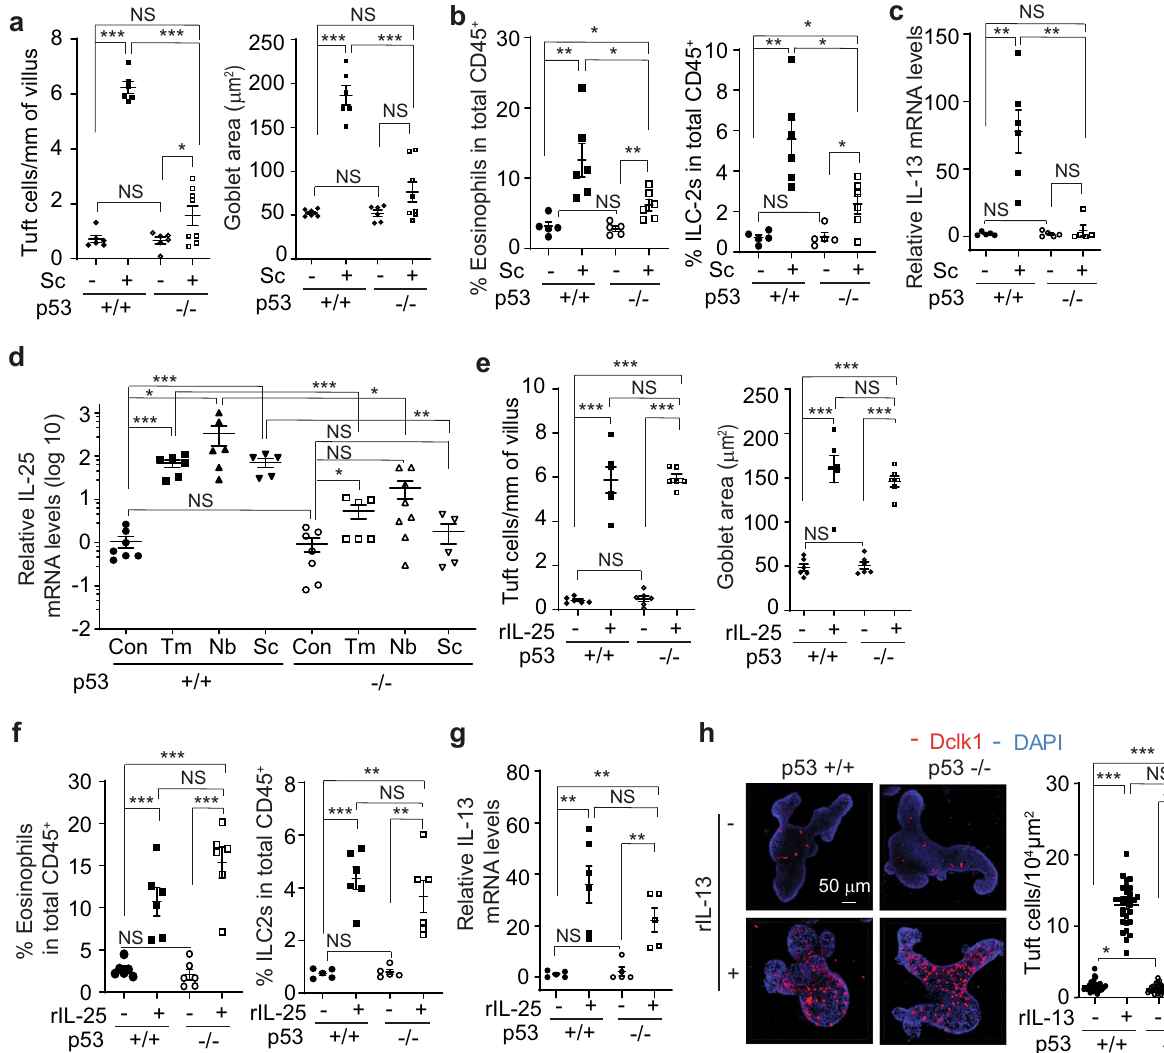
Fig. 2 p53 de fi ciency impairs the function of tuft cells to trigger type 2 immunity. a – c p53 + / + and p53 − / − mice were given drinking water with or without 150 mM succinate (Sc) for 7 days before analysis. a . Quanti fi cations of tuft (left) and goblet cells (right) in the small intestine of mice treated with or without succinate by IHC staining of Dclk1 and Alcian blue staining, respectively. b Quanti fi cations of eosinophils and ILC2s in the LP by fl ow cytometric analysis. c Relative mRNA levels of IL-13 in the small intestine. In c , d, and g , mRNA levels were determined by quantitative real-time PCR and normalized with β -actin. d Relative mRNA levels of IL-25 in the intestinal epithelium of naïve mice, mice infected with Tm or Nb , and mice treated with succinate. e – g p53 + / + and p53 − / − mice were treated with rIL-25 (0.5 µ g/day; i.p .) or PBS for 7 days before analysis. e Quanti fi cations of tuft (left) and goblet cells (right) in the small intestine. f Quanti fi cations of eosinophils and ILC2s in the LP. g Relative mRNA levels of IL-13 in the small intestine. h rIL-13 induced tuft cell expansion in p53 + / + and p53 − / − intestinal organoids to a similar extent. The intestinal organoids from p53 + / + and p53 − / − mice were treated with rIL-13 (10 ng/ml for 48 h) or PBS, and then tuft cells were detected by IF staining of Dclk1. Left: representative images. Right: quanti fi cations of tuft cells. For a – h , data are presented as mean ± SEM. For a – g , each dot represents an individual mouse. n = 5 – 8/group. For h , each dot represents an image fi eld. * p < 0.05; ** p < 0.01; *** p < 0.001; NS: non-signi fi cant, two-tailed Student ’ s t